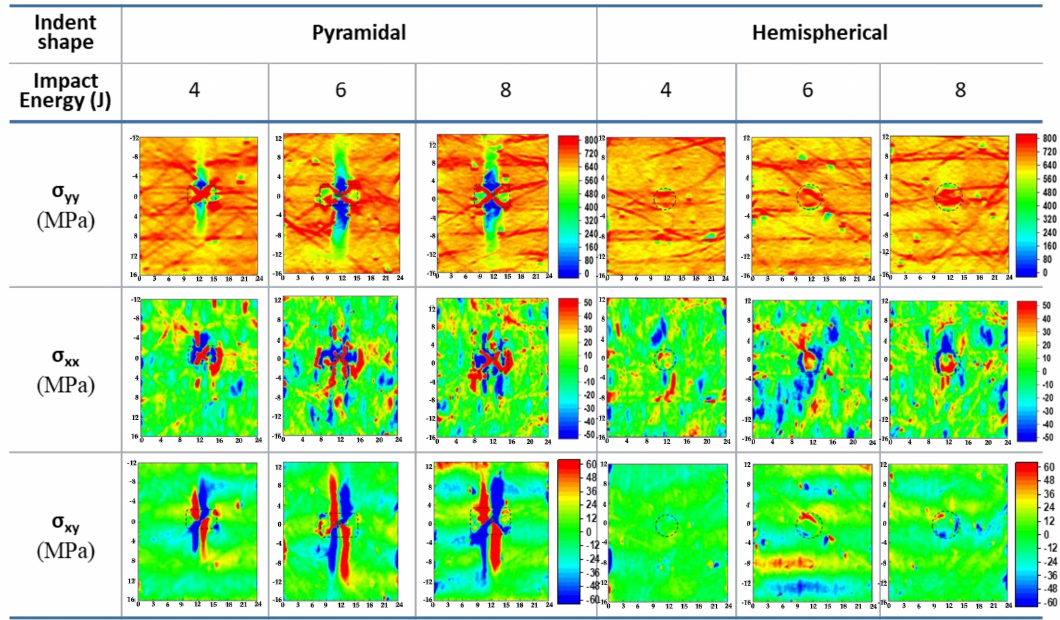
Figure 10. Typical directional stress, longitudinal ( σ yy ), transverse ( σ xx ) and shear ( σ xy ) stresses, distribution in the vicinity of the indents for UD GFRP laminates (at tensile stress of 700 MPa).